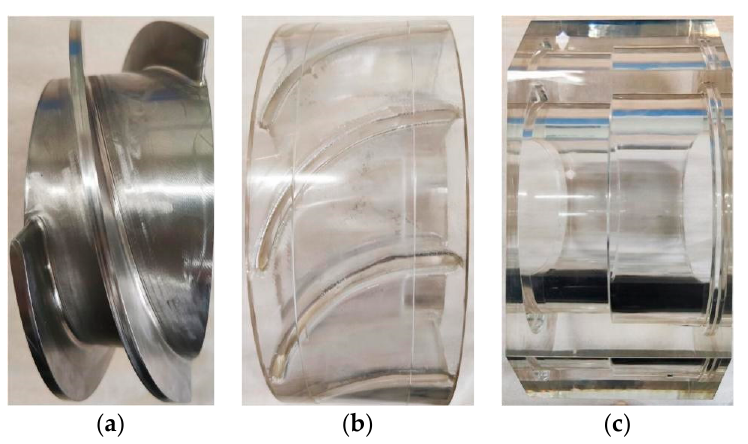
Figure 4. Physical model of the helico-axial pump. ( a ) impeller ( b ) diffuser ( c ) pump body.